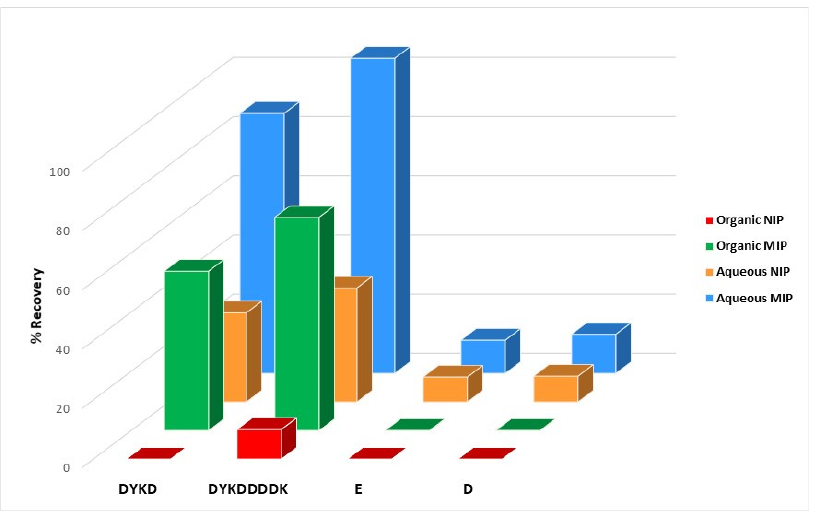
Figure 9. Recoveries (%) obtained after elution for DYKD, DYKDDDDK, E, and D compounds for a fixed concentration of 5 mg ∙ L − 1 each following the whole MISPE process.